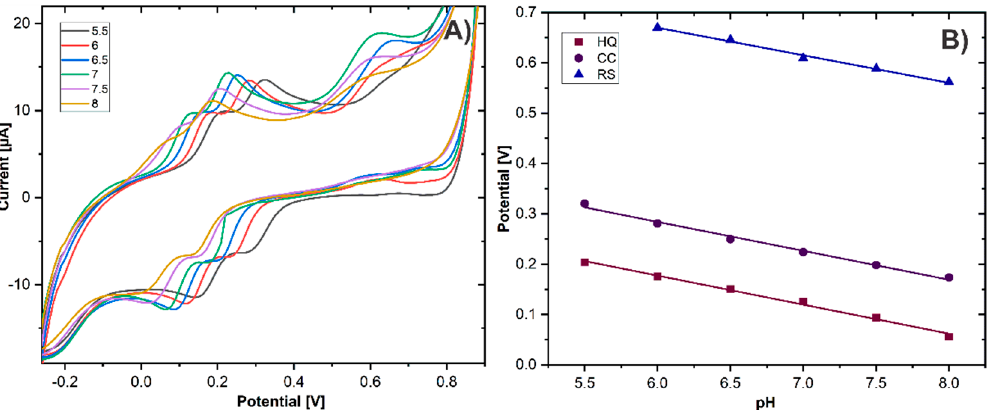
Figure 6. ( A ) Cyclic voltammetry of GCE/ErGO-cMWCNT/AuNPs for a mixture of 0.2 mM of HQ, CC, and RS in different pH solutions at 50 mV s − 1 . ( B ) Plots of effects of anodic peak potential vs. pH. The slopes of the three regression equations were − 0.0578 V pH − 1 , − 0.0575 V pH − 1 ,